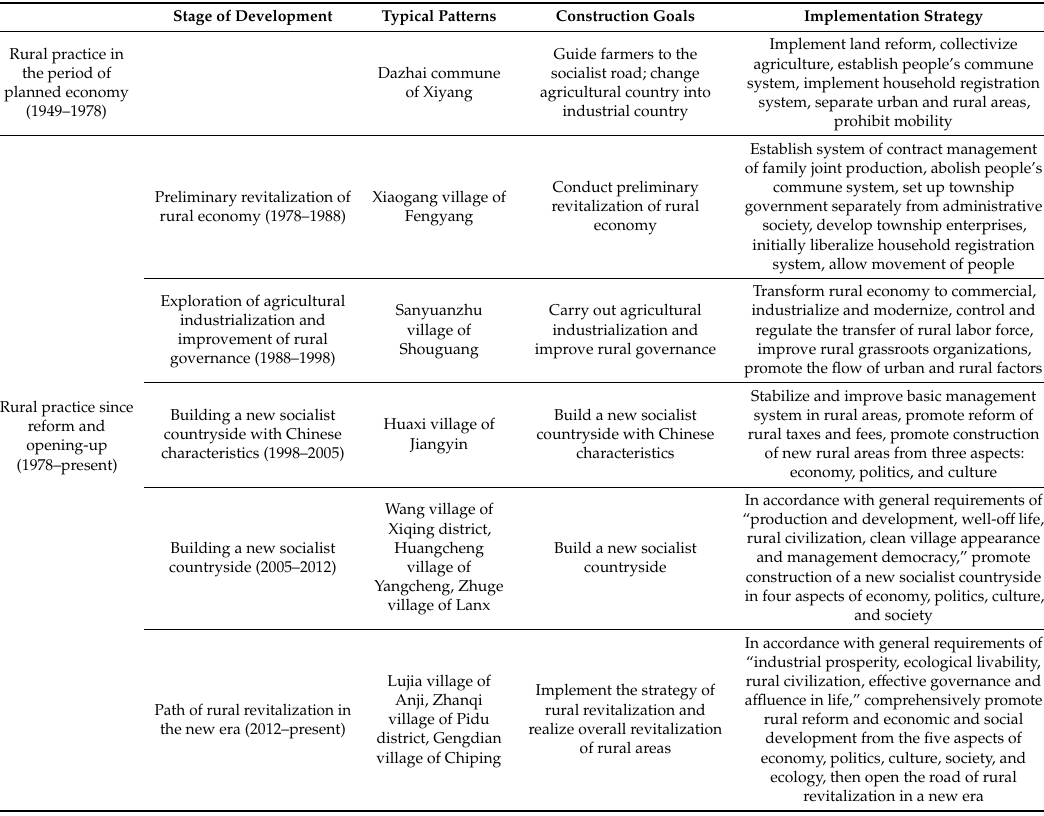
Table 1. Exploration and practice of rural revitalization in the 70 years since the founding of the People’s Republic of